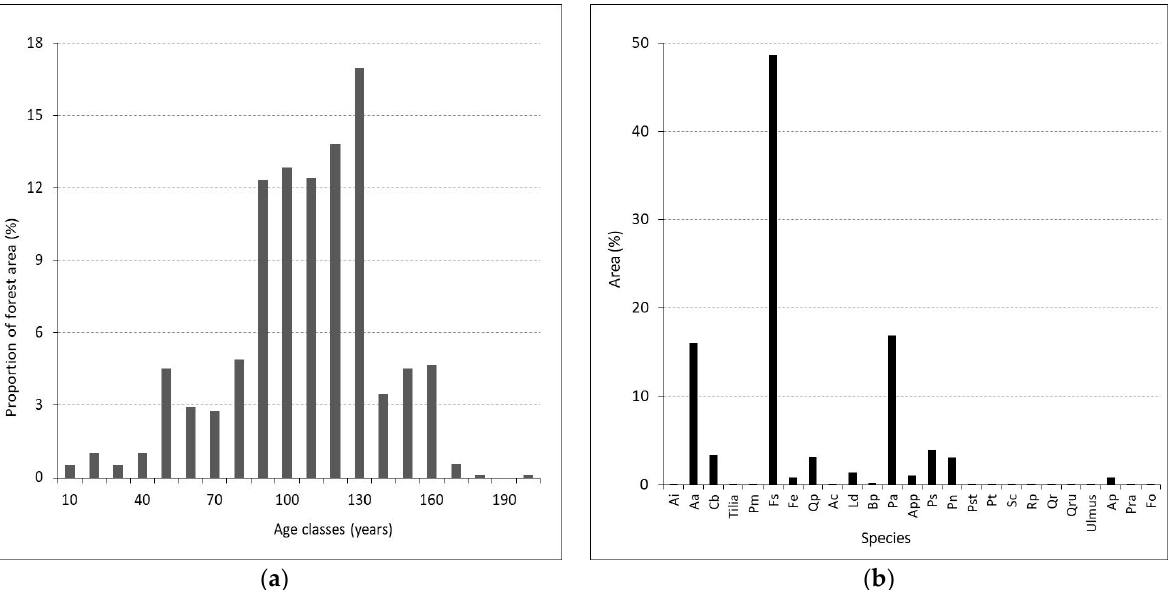
Figure 2. ( a ) Forest age structure and ( b ) proportion of species (% of area) identified in the forest composition. The age class division used was based on the ages of the trees of the different species. Each age class included generations of trees in the stands. Ai—Alnus incana L.; Aa — Abies alba Mill.; Cb — Carpinus betulus L.; Tilia — Tilia spp. L.; Pm — Pseudotsuga menziesii ; Fs — Fagus sylvatica L.; Fe — Fraxinus excelsior L.; Qp — Quercus petraea L.; Ld — Larix decidua Mill.; Bp — Betula pendula Roth; Pa — Picea abies Karst.; App — Acer pseudoplatanus L.; Ps — Pinus sylvestris L.; Pn — Pinus nigra Arn.; Pst — Pinus strobus L.; Pt — Populus tremula L.; Rp — Robinia pseudoacacia L.; Qr — Quercus robur L.; Qru — Quercus rubra L.; Ulmus — Ulmus spp. L.; Ap — Acer platanoides L.; Pra — Prunus avium L.; Fo — Fraxinus